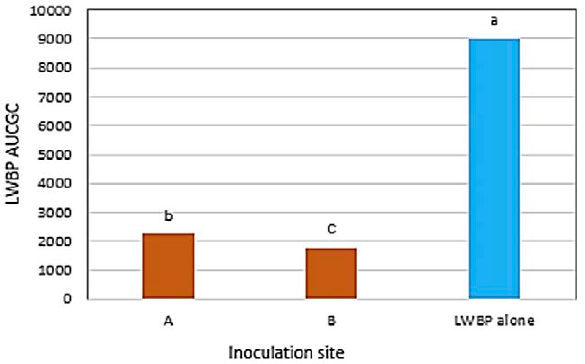
Figure 7. Effect of grafting site on concentration of lime witches’ broom phytoplasma (LWBP) (16SrII-B) in mixed grafting and alone: LWBP AUCGC, area under concentration growth curve of LWBP; A, inoculation of the alfalfa witches’ broom phytoplasma (AWBP) (16SrII-C), rapeseed phyllody phytoplasma (RPhP) (16SrI- B), sesame phyllody phytoplasma (SPhP) (16SrIX-C) and tomato witches’ broom phytoplasmas phytoplasma (TWBP) (16SrII-D) phytoplasmas above the site of the LWBP grafting and B, inocu- lation of the AWBP, RPhP, SPhP and TWBP below the site of the LWBP grafting. A and B are means of the four mixed inoculations. Means with different letters are significantly different ( P ≤